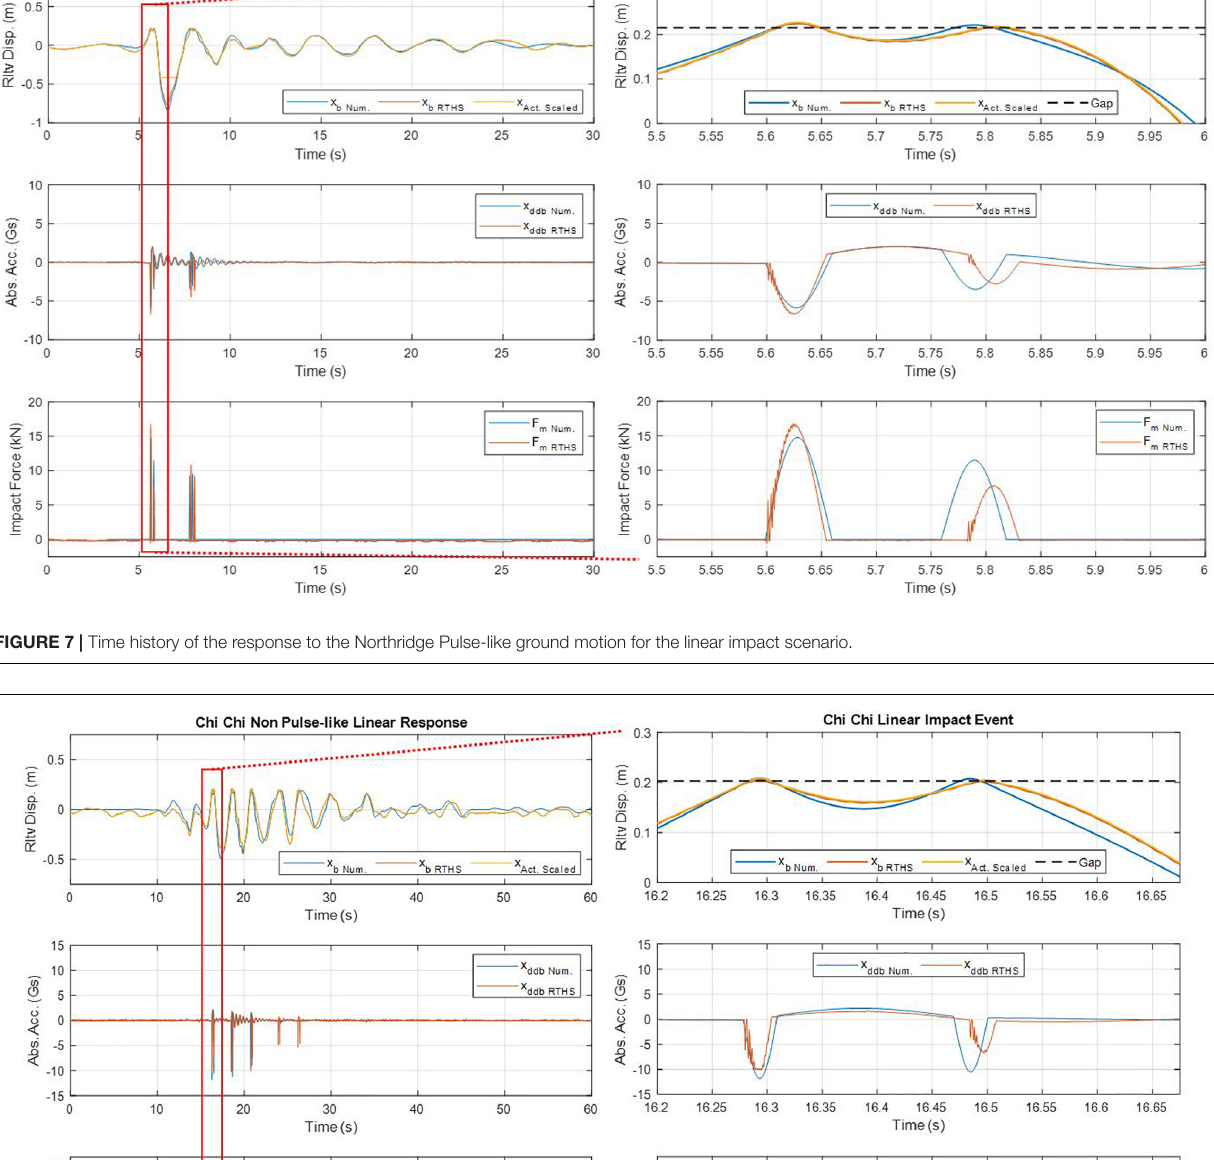
impact scenario, the RTHS test results are compared to the numerical results obtained using the bilinear approximation of the F-D behavior of the physical substructure. The RTHS